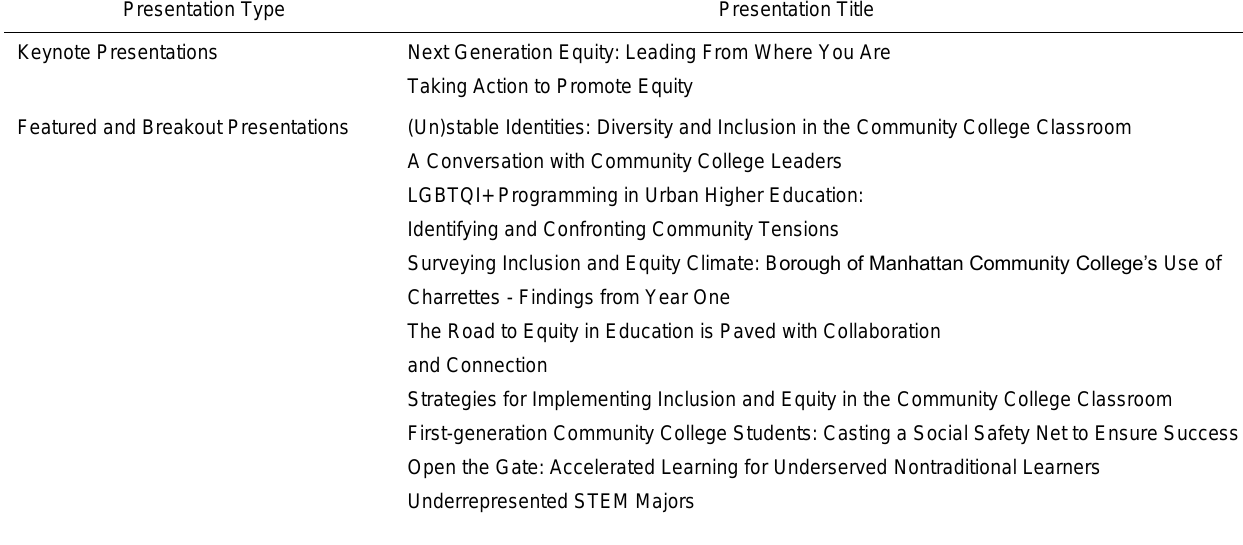
Table 3. Community College Showcase Sample Sessions Presentation